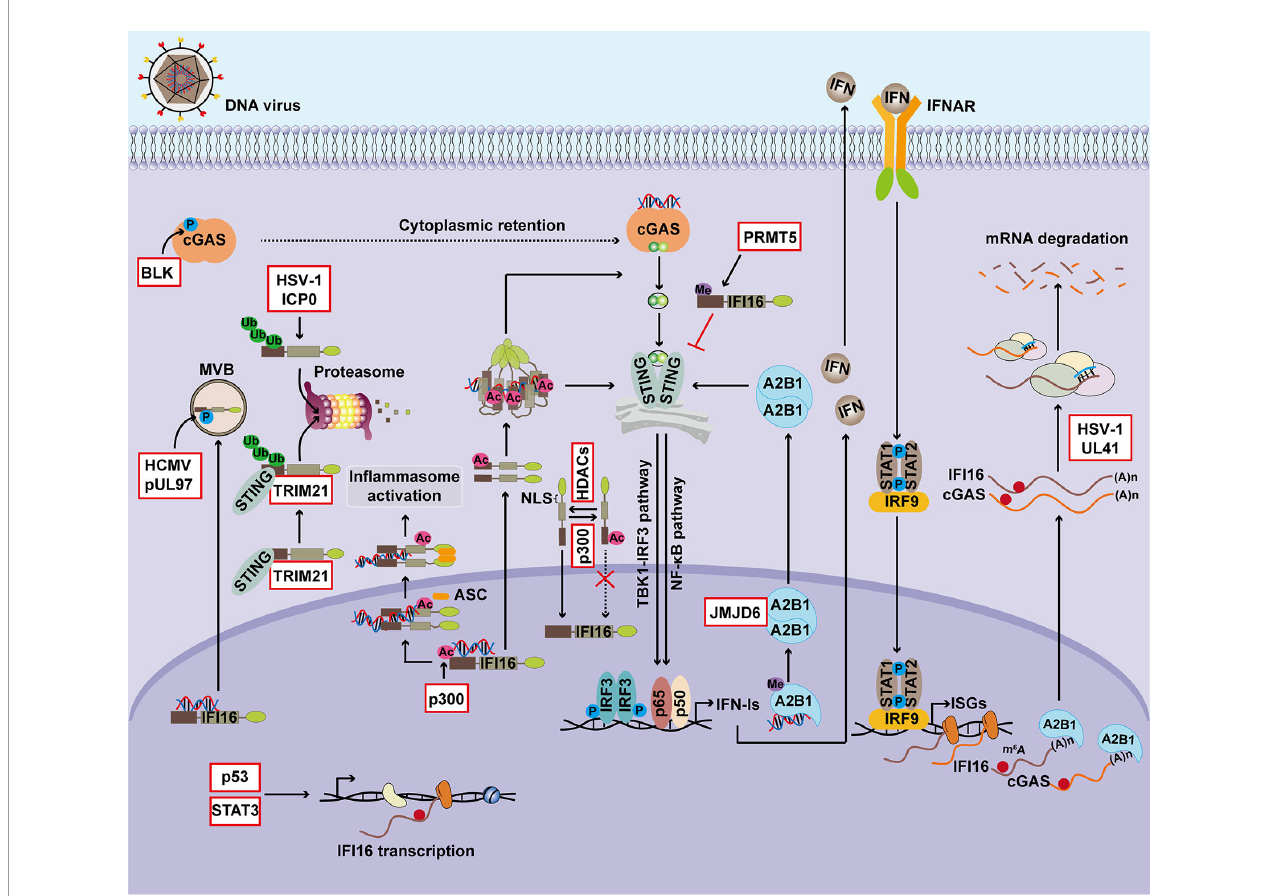
FIGURE 2 | Regulation of nuclear DNA sensors. The expression and activation of DNA sensors are fi nely controlled during viral infection and tumorigenesis. p53 facilitates IFI16 transcription by directly binding to the promoter region of IFI16, and IL-6 drives IFI16 transcription in a STAT3-dependent manner. Post-transcriptional regulation also involves modulating the expression of nuclear DNA sensors. During DNA virus infection, hnRNPA2B1 functions as an m 6 A modulator to promote nucleocytoplasmic traf fi cking of cGAS and IFI16 mRNAs. UL41 from HSV-1 signi fi cantly reduces the expression of cGAS and IFI16 by degrading their transcripts. Furthermore, PTMs, particularly the phosphorylation, ubiquitination, acetylation, and methylation, play critical roles in regulating the activity and stability of nuclear DNA sensors. Phosphorylation of IFI16 controls its subcellular localization, and related antiviral immunity and BLK-mediated phosphorylation of cGAS facilitates its cytosolic retention. ICP0 from HSV-1 induces the ubiquitination and proteasome-dependent degradation of IFI16 and thus suppresses in fl ammasome activation. STING promotes IFI16 degradation via the ubiquitin-proteasome system by TRIM21. The acetyltransferase p300 mediates acetylation of IFI16 during HSV-1 infection, an essential step for in fl ammasome assembly and cytoplasmic translocation, activation of cytoplasmic STING signaling, and downstream IFN- b production. The sensing ability of IFI16 is modulated by acetylation of Lys99 and Lys128 within its NLS, and this PTM of IFI16 promotes the cytoplasmic translocation of IFI16, whereas HDACs promotes its nuclear import. hnRNPA2B1 is demethylated by JMJD6 in the HSV-1-infected cells, which consequently initiates IFN- a / b production and enhances STING-dependent cytoplasmic antiviral signaling. BLK, B-lymphoid tyrosine kinase; MVB, multivesicular bodies; ICP0, human HSV-1 infected cell polypeptide 0; TRIM21, tripartite motif-containing protein 21; Ub, Ubiquitination; Ac, Acetylation; Me, Methylation; STAT3, signal transducer and activator of transcription 3; NLS, nuclear localization signal; HDAC, histone deacetylase; PRMT5, protein arginine N-methyltransferase